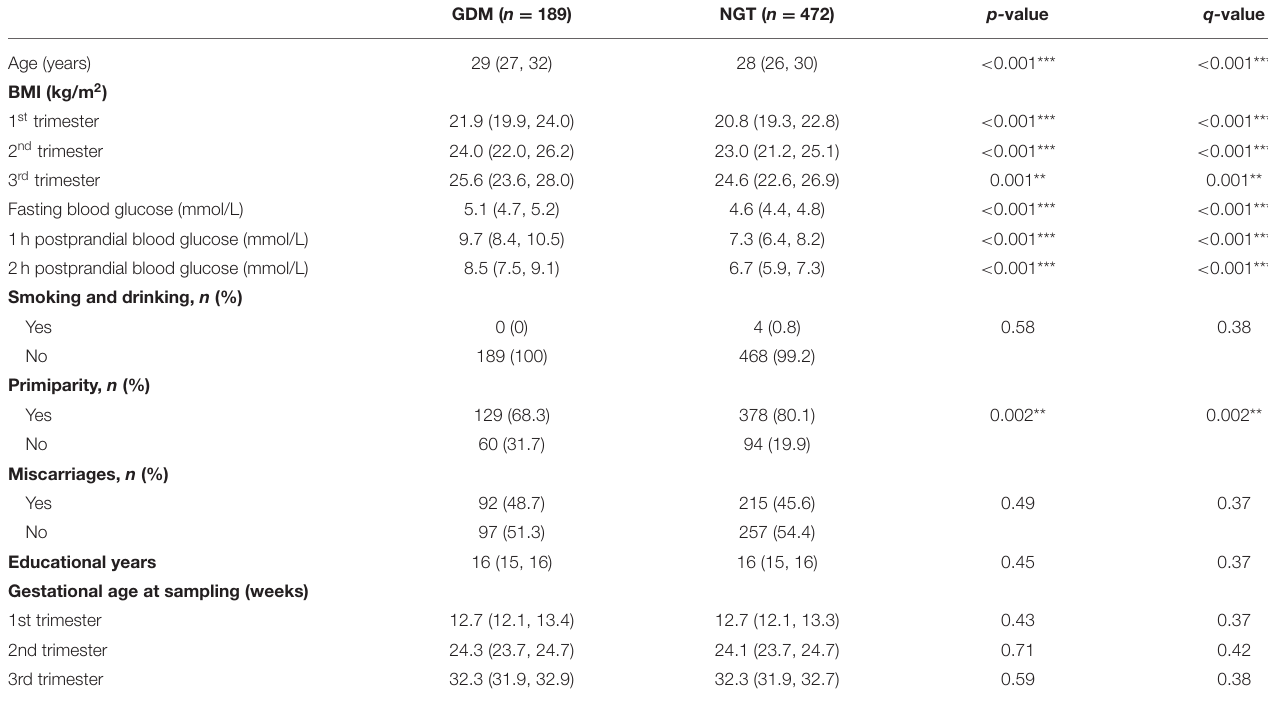
TABLE 1 | Clinical characteristics of pregnant women with normal glucose tolerance (NGT) and gestational diabetes mellitus